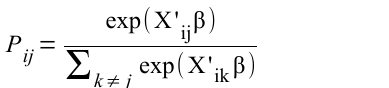
Table A1.4) that included respondent